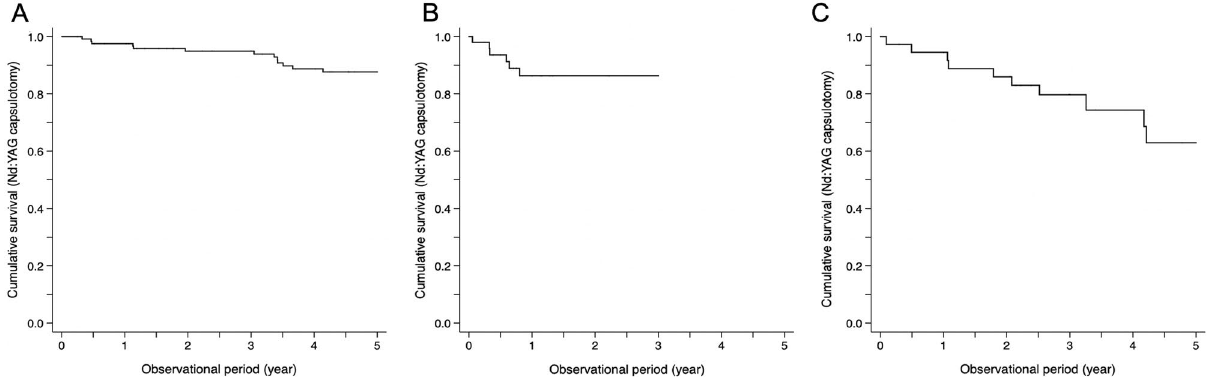
Figure 2. Cumulative survival curves of Nd:YAG capsulotomy. ( A ) Acrysof group. ( B ) iSert XY-1 group. ( C ) iSert 251/255 group. A difference is observed at the initial time point. The incidence of Nd:YAG capsulotomy over the 5-year follow-up is significantly lower in the Acrysof group than in the iSert group (log-rank test, p < 0.001).